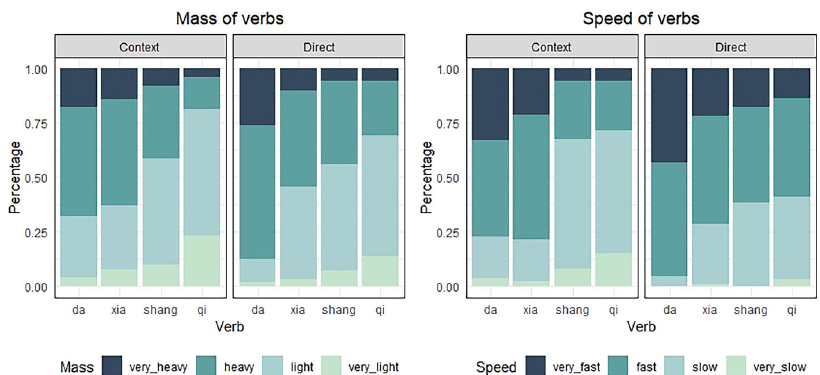
Fig. 1 Ratings of Mass and Speed across conditions and verbs by native Sinitic language speakers. The graph on the left shows the ratings to Mass of verbs and the one on the right indicates the ratings to Speed of verbs, which were elicited either directly (Direct) or via a pseudo-weather event (Context). The participants were instructed to rate on a four-point scale ( ‘ very heavy/fast ’ , ‘ heavy/fast ’ , ‘ light/slow ’ and ‘ very light/slow ’ ), as represented by different